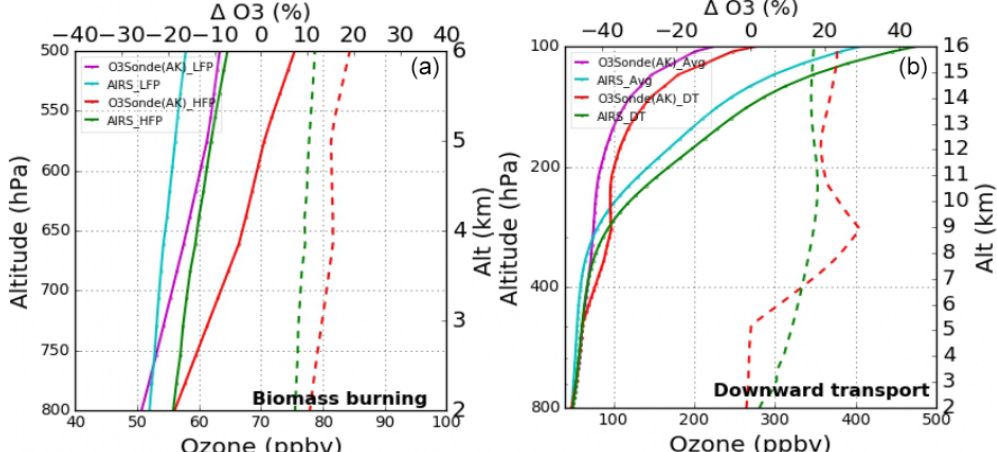
Figure 10. (a) Vertical ozone profiles of AIRS ozone and ozonesonde (AK) during low fire period (LFP) and high fire period (HFP). The solid lines correspond to ozone profiles, while the dotted lines show a percentage increase in ozonesonde (red) and AIRS (green) profiles during biomass burning events. (b) Vertical ozone profiles of AIRS ozone and ozonesonde (AK) during events of downward transport. The dotted line shows ozone enhancement during downward transport